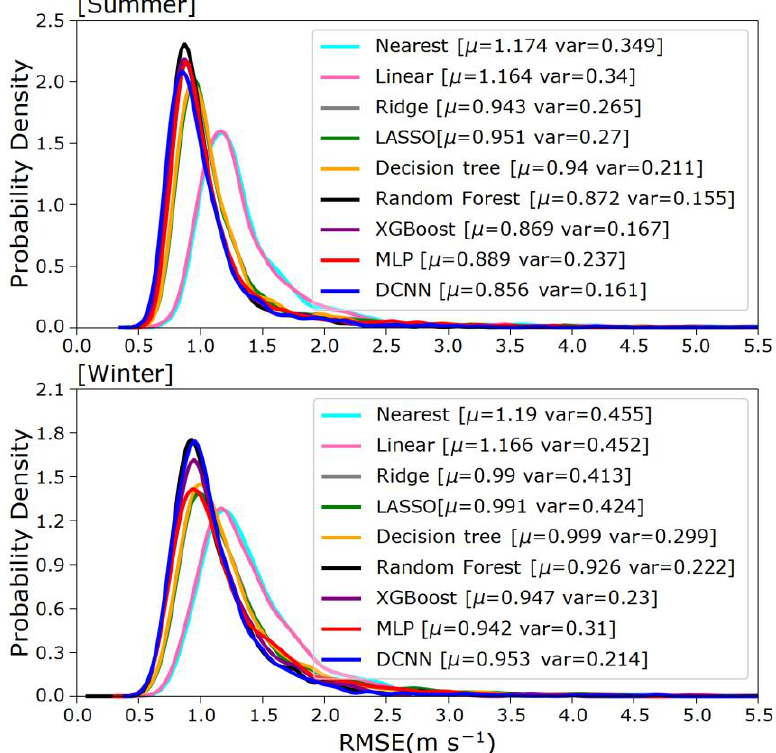
Figure 3. Probability density distribution of RMSEs of interpolation results for eastern China from different methods ( µ : RMSE value corresponding to the peak, var: variance of all RMSEs).